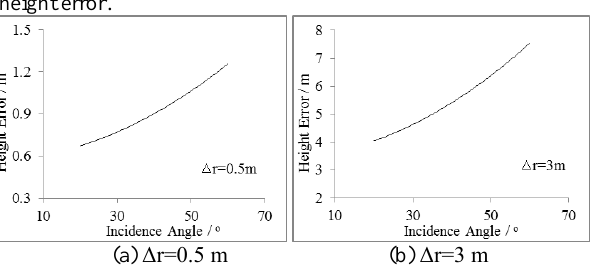
Figure 7. The relationships between the incidence angle and height error